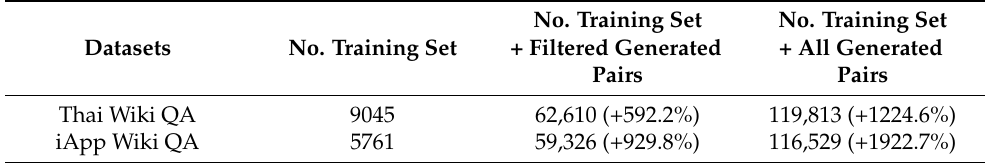
Table 6. Dataset statistics after combining with generated